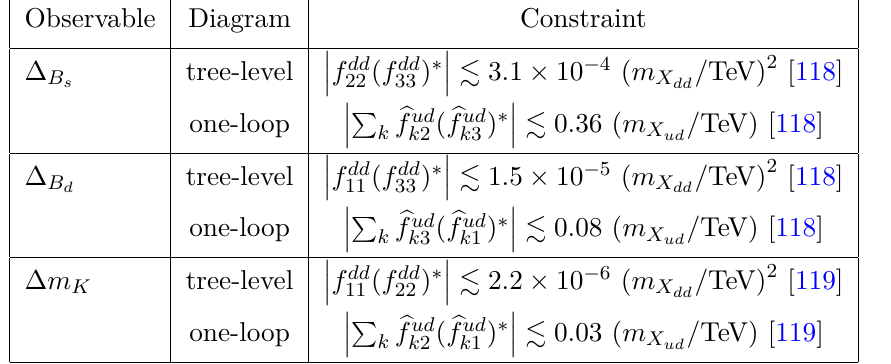
, B 0 , and K 0 − K 0 − B 0 − B 0 s s d d